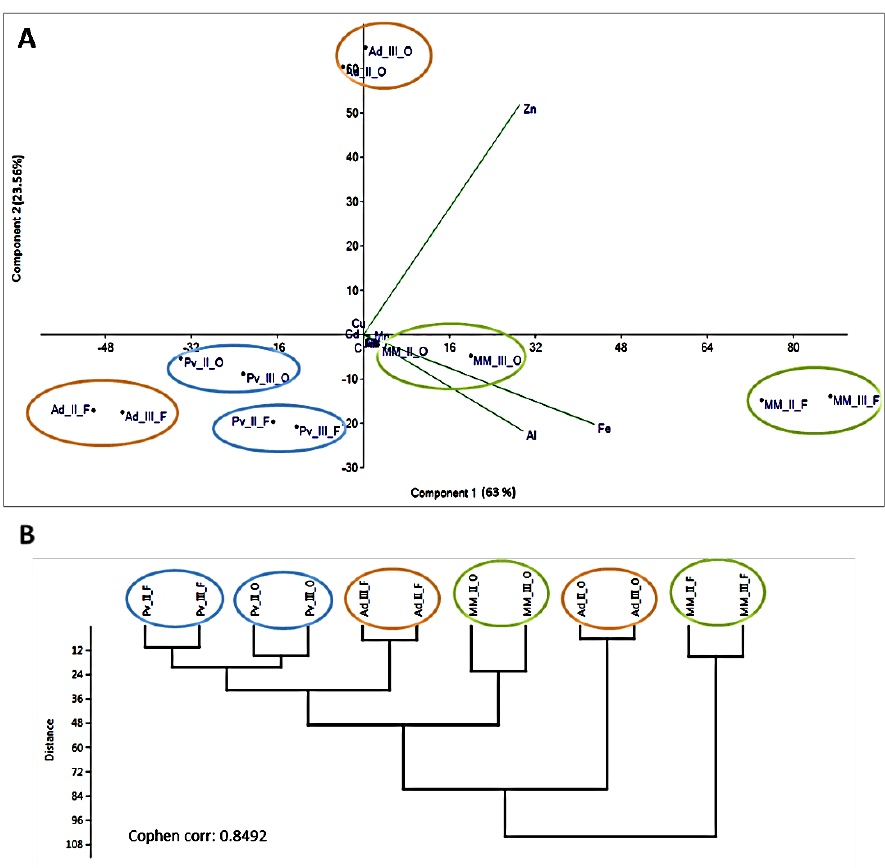
Figure 3. PCA biplot ( A ) and clustering analysis ( B ) based on the accumulation of 12 metals (Al, Cr, Mn, Fe, Co, Ni, Cu, Zn, As, Mo, Cd and Pb) in the biomass of A. donax L. (Ad), switchgrass (Pv) and mixed meadow (MM), considering the year of cultivation, second (_II) and third (_III), and the harvest time (October: _O and February: _F). In PCA analysis the first two axes (PC1 and PC2) explain 86.56% of the total variance.